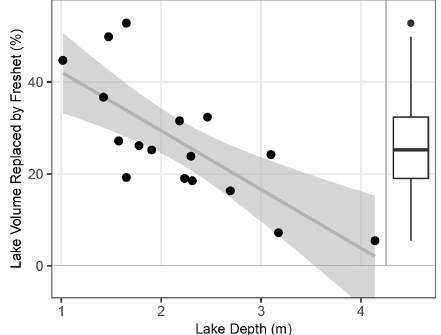
Figure 6. The relationship between the amount of lake water re- placed by freshet and lake depth. The distribution of lake water replacement by freshet is shown by the boxplot on the right-hand side of the plot. A linear regression is also displayed on the plot ( R 2 = 0 . 53, p < 0 . 001). The shaded grey area represents the 95% confidence interval of the linear